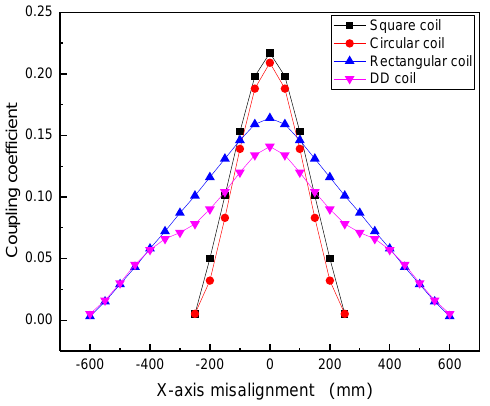
Figure 6. Coupling coefficient versus the X -axis misalignment.